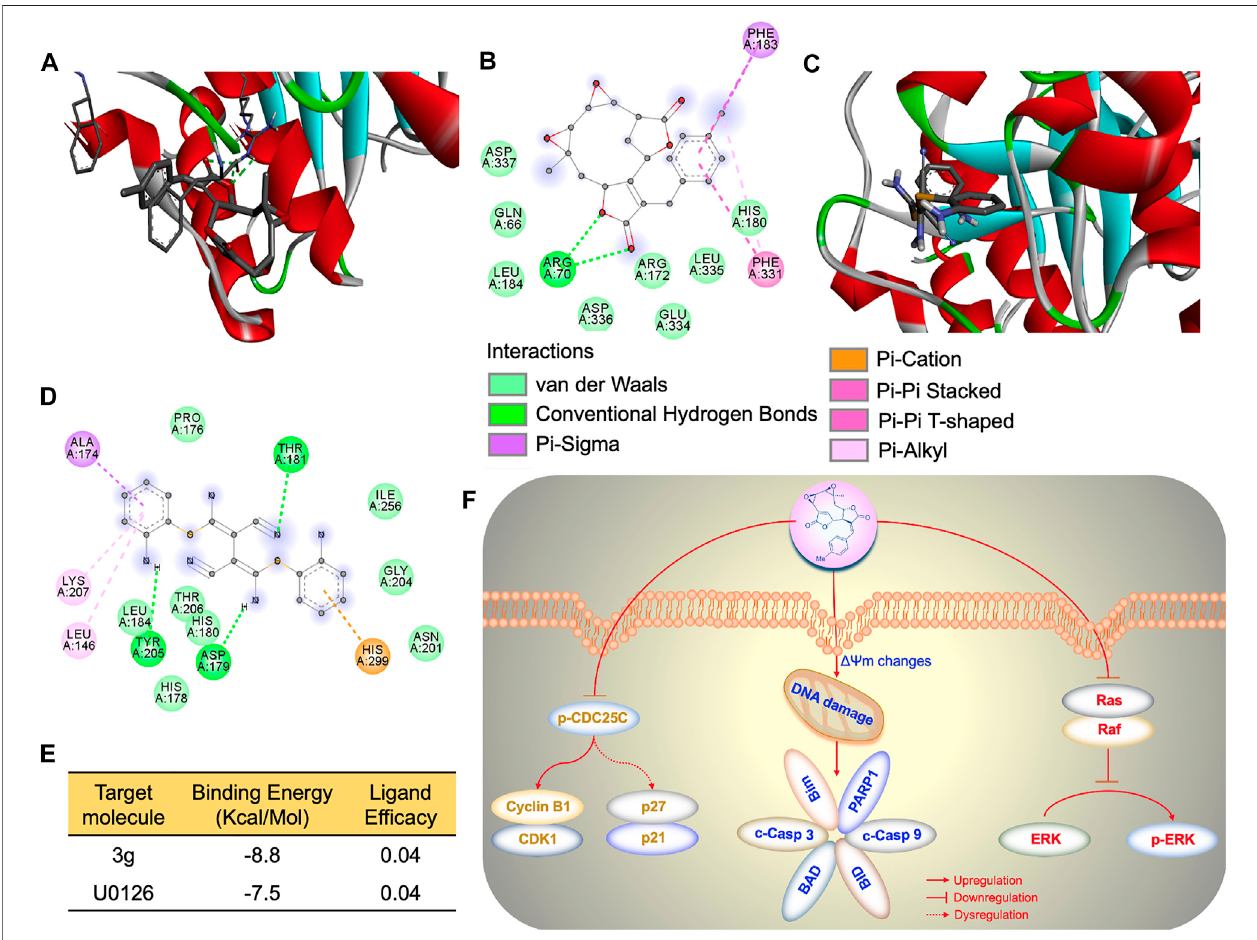
FIGURE6| 3gcausep-ERKinhibition. (A) AutoDock3DimagedepictingtheinteractivesitebetweenU0126andERK. (B) AutoDock2Daminoacidinteractivesite imagebetweenU0126andERK. (C) AutoDock3Dimagedepictingtheinteractivesitebetween3gandERK. (D) AutoDock2Daminoacidinteractivesiteimagebetween 3g and ERK. (E) Binding energy and ligand ef fi ciency between ERK and ligands. (F) Molecular mechanism of 3g as an antileukemic